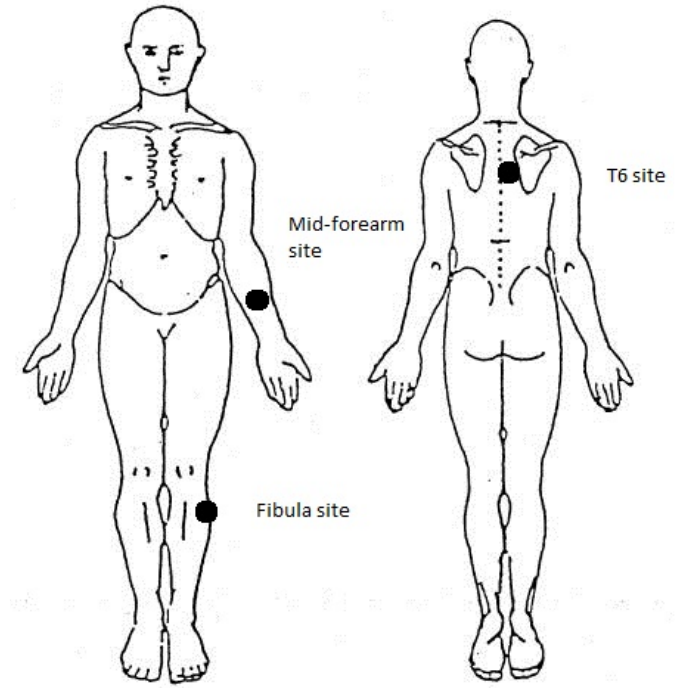
Figure 1. PPT measurement sites: T6 site (paravertebral 3 cm to the right of the T6 spinous process), Mid-forearm site (midway between left wrist and elbow over the anterior ulna), Fibula (2 cm below the left head of